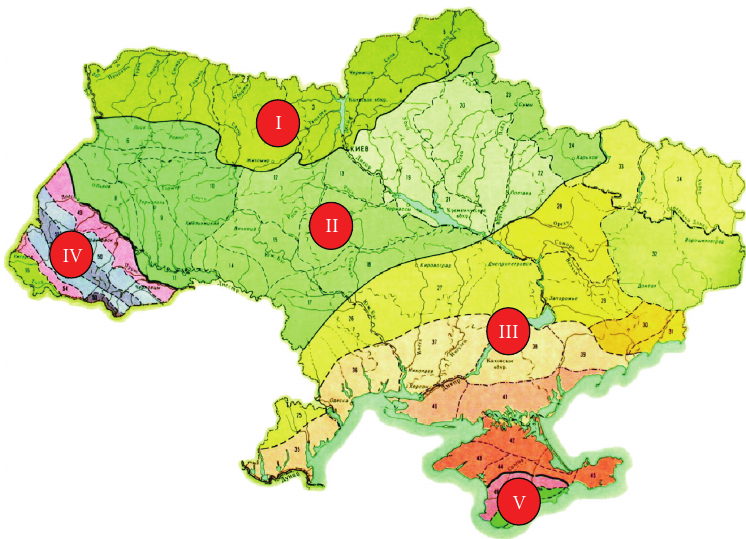
Figure 1: Geographical regions of Ukraine (zone limits are market in continuous line). I: the zone of mixed coniferous-broad-leaved forests; II: forest-steppe zone; III: steppe zone; IV: the Ukrainian Carpathians; V: the Crimean